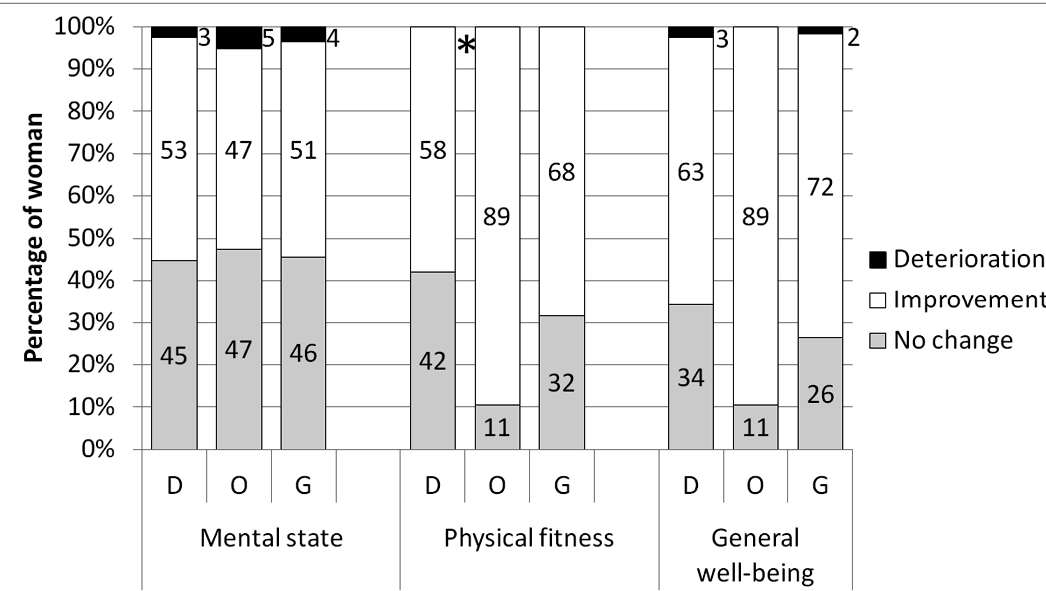
Figure 4. Percentage of women declaring different effects of SR-WBV training on individuals in the D program (N = 38), O program (N = 19), and altogether—G (the entire group of women) (N = 57); * p < 0.05.